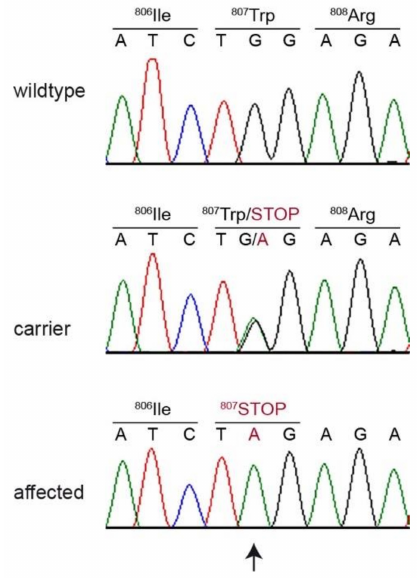
Figure 2. Details of the HPS3 :c.2420G > A variant. Representative electropherograms of three dogs with di ff erent genotypes are shown. The variable position is indicated by an arrow, and the amino acid translations are